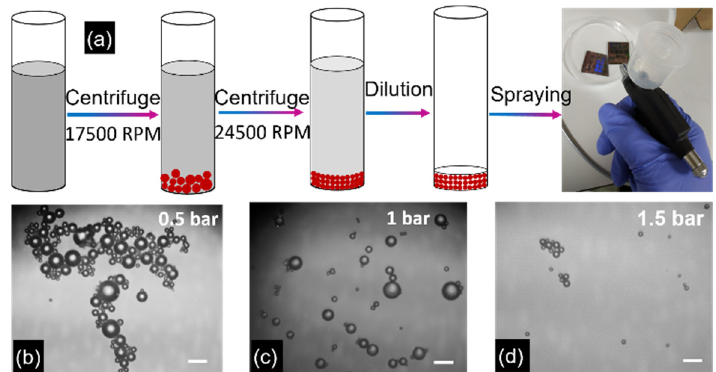
Figure 2. ( a ) Schematic illustration of fabrication procedure of TiO 2 microspheres, starting from two separate centrifuges, followed by dilution and spraying using an air gun. ( b – d ) Fabricated TiO 2 microspheres as the function of applied air gun pressure using 0.5, 1, and 1.5 bar, respectively. Scale bar: 20 μ m.